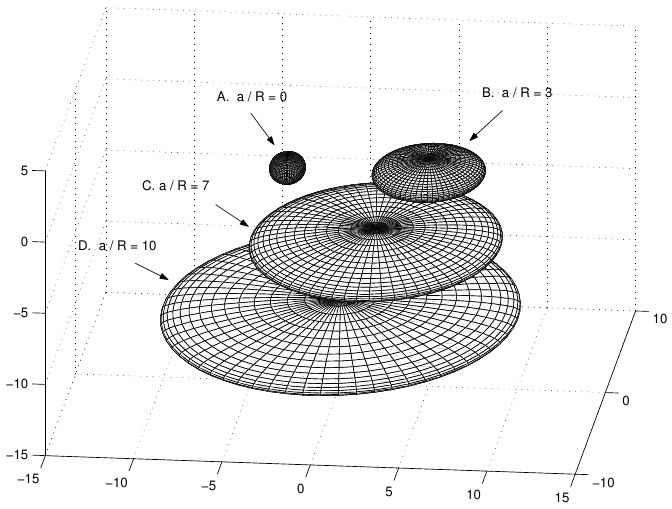
Figure 2. Disk-like source of the regularized solution of Kerr–Newman (KN) as a bag model. Deformation of the disk at different ratios of parameters R = r e and a . For r e = e 2 /2 m , the disk is very thin, and r e / a = α corresponds to the fine structure